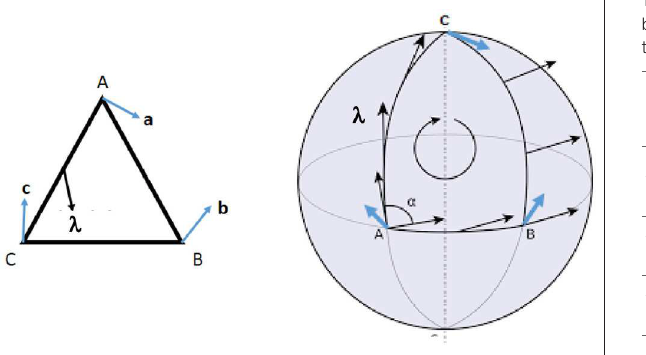
FIGURE 3 | Two closely related, though intrinsically different, random games: the game on the left hand side is constrained by the Bell inequality, while the one on the right hand side is not necessarily constrained by the inequality. In both games we have reference unit vectors, labeled, respectively as c , drawn at each one of the vertices, labeled as A , B , and C , of a triangle. In E the game on the left the triangle is drawn on a plane surface and the reference unit vectors are contained within the plane, while in the game on the right the “triangle” is defined on the surface of a sphere by segments of three great circles and the three reference unit vectors lay within the corresponding tangent planes. Two copies of a randomly oriented unit vector E λ are generated at random at the center of one of the three segments of the triangle with density of probability ρ ( E λ ), and detected, respectively, at the two detectors located at the ends of the segment. In the game on the left the vector E λ is contained within the plane surface, while in the game on the right the vector E λ is tangent to the sphere. The binary responses of the detectors are locally defined by parallelly transporting the unit vector E λ along the segment of the triangle to its end, and comparing its orientation to the orientation of the